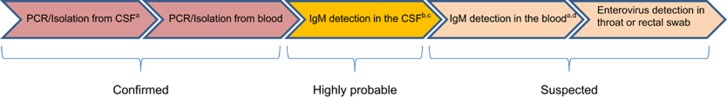
A decision tree used in the study to prioritize the importance of results in determining the final conclusion for aetiology. Ranking of the primacy of results is from left (most reliable) to right (least reliable). aDetection of CMV or EBV in the CSF was categorized as ‘highly probable’ due to the possibility of reactivation of latent virus. bIgM detection was considered positive when the optical density (OD) of the samples was greater than the mean OD of three negative control samples plus 3 standard deviations. cIgM detection in the CSF was only considered positive when the CSF IgM titre was higher than blood IgM titre for the corresponding virus. dAn acute infection was defined as a significant increase in OD measured for IgM by ELISA between admission and discharge sera.